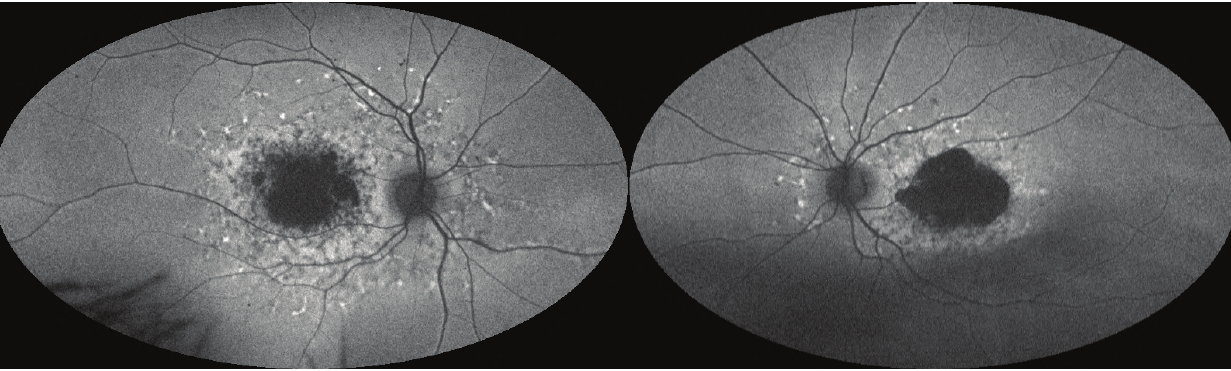
Figure 6. Green light ultrawide field fundus autofluorescence (UWF-FAF) (Optos) of a patient with Stargardt disease. Note the dense foveal hypoautofluorescence (hypo-AF), retinal pigment epithelial (RPE) atrophy. Perimacular hyperautofluorescent (hyper- AF) flecks comprised of lipofuscin buildup extend toward the mid-periphery. Hypo-AF flecks likely indicate prior lipofuscin deposits that resulted in RPE atrophy. Peripapillary sparing of these deposits is characteristic of Stargardt